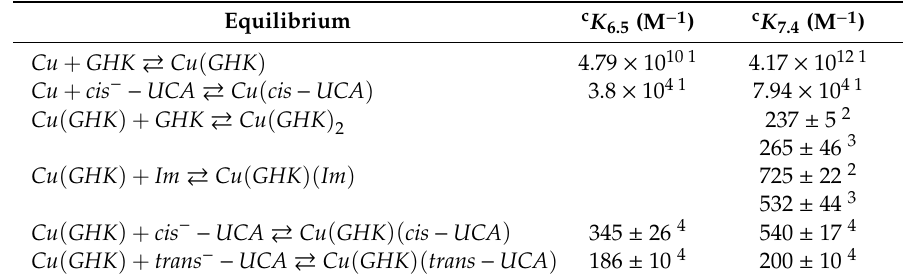
Table 2. Binding constants of binary Cu(II) complexes of GHK, and ternary Cu(II) complexes of GHK with imidazole-bearing ligands at pH 6.5 and 7.4, at 25 ◦ C.